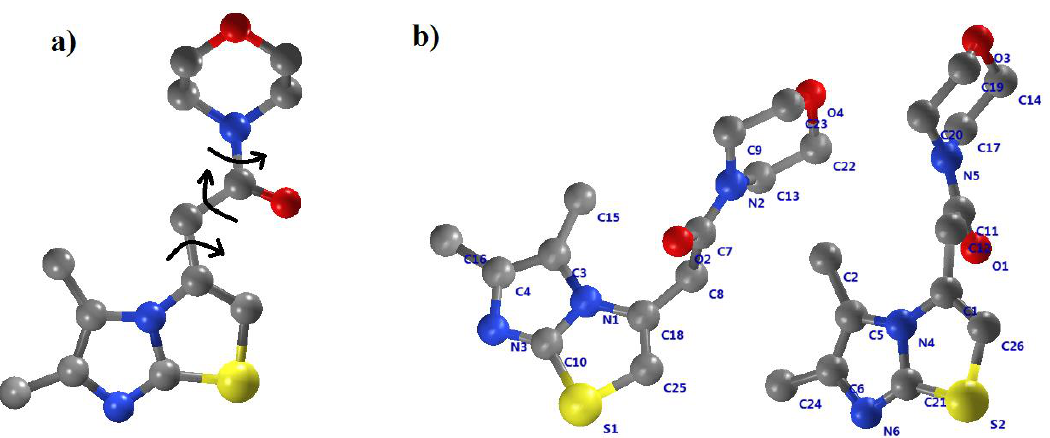
Figure 6. 2-(5,6-dimethylimidazo[2,1-b]thiazol-3-yl)-1-morpholinoethanone (chemical formula C 13 H 17 N 3 O 2 S (hydrogen atoms are not considered)): ( a ) the starting model used in the Simulated Annealing (SA) solution process in EXPO; ( b ) the SA solution.